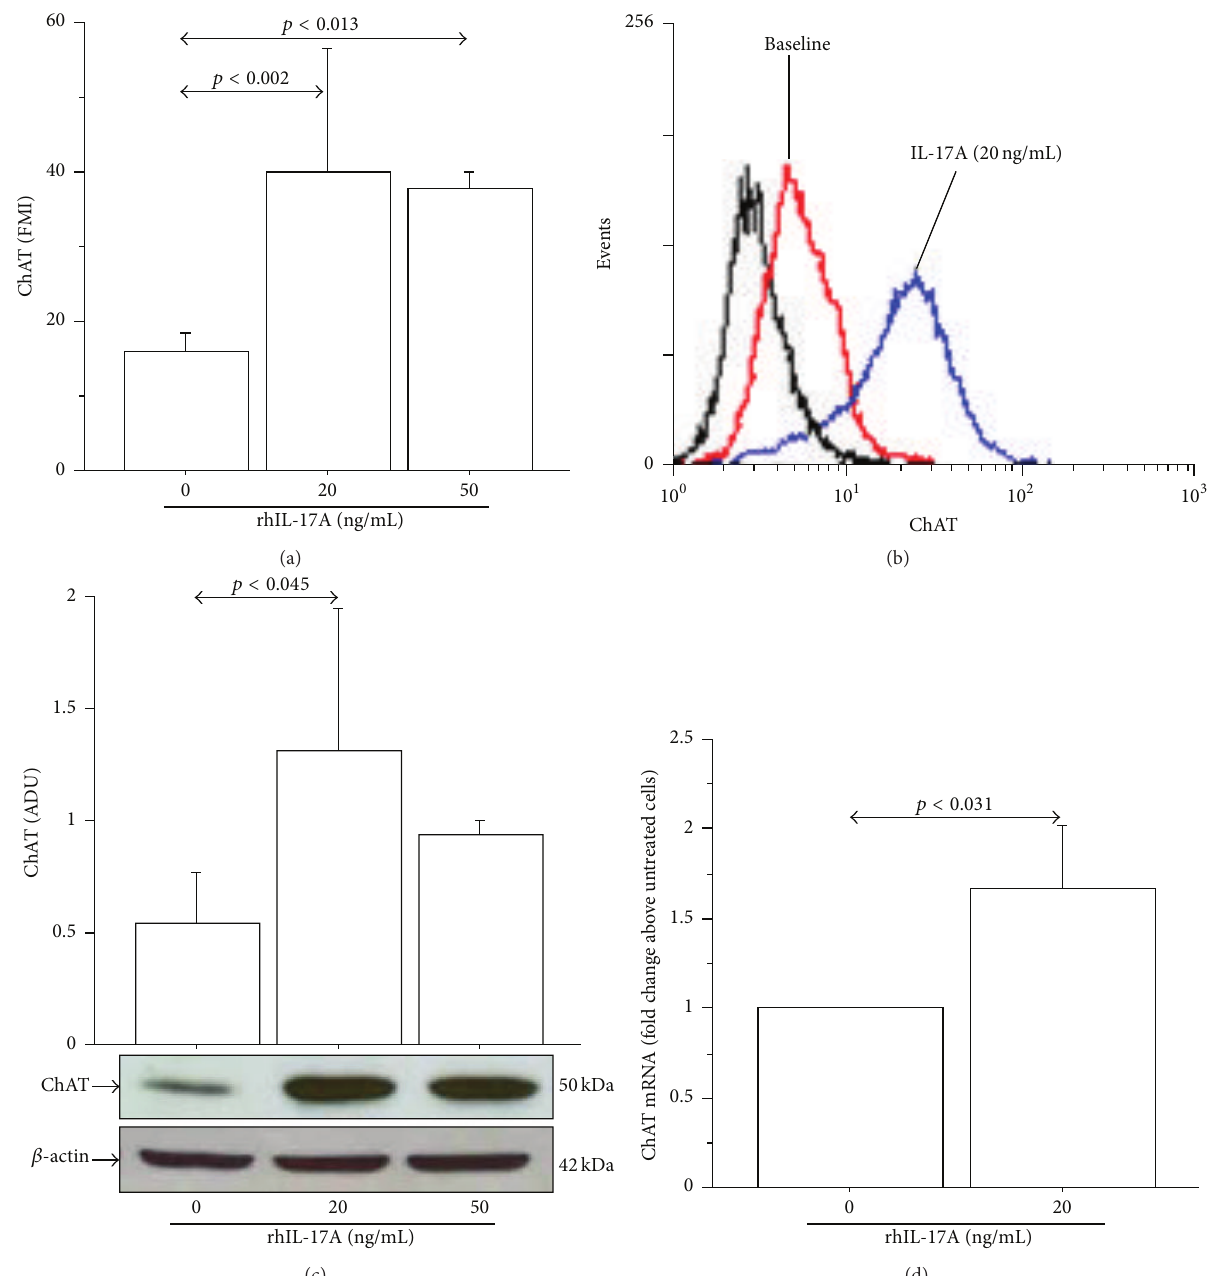
Figure 1: rhIL-17A increased ChAT protein expression and mRNA in 16-HBE cells. Cells were stimulated with rhIL-17A (0–50ng/mL) for 24 h to evaluate ChAT protein expression (a) by flow cytometry. Bars represent mean ± SD of fluorescence mean intensity (FMI) of three separate experiments. Representative (b) flow cytometry analysis and western blot (c) are shown. Bars represent mean ± SD of arbitrary densitometric units (ADU). Representative western blot analysis of ChAT protein and 𝛽 -actin is shown. (d) Cells were stimulated with rhIL-17A (0–20 ng/mL) for 24 h to evaluate ChAT mRNA levels by RT-PCR. Bars represent mean ± SD of arbitrary units of three separate experiments and were plotted as fold change compared to untreated cells. Statistical analysis was performed by ANOVA test followed by Fisher’s PLSD multiple comparison test or Student’s 𝑡 -test. The black curve represents the anti-IgG isotype negative control antibody. rhIL-17A 20 ng/mL compared with the cells stimulated with rhIL-17A alone (Figure